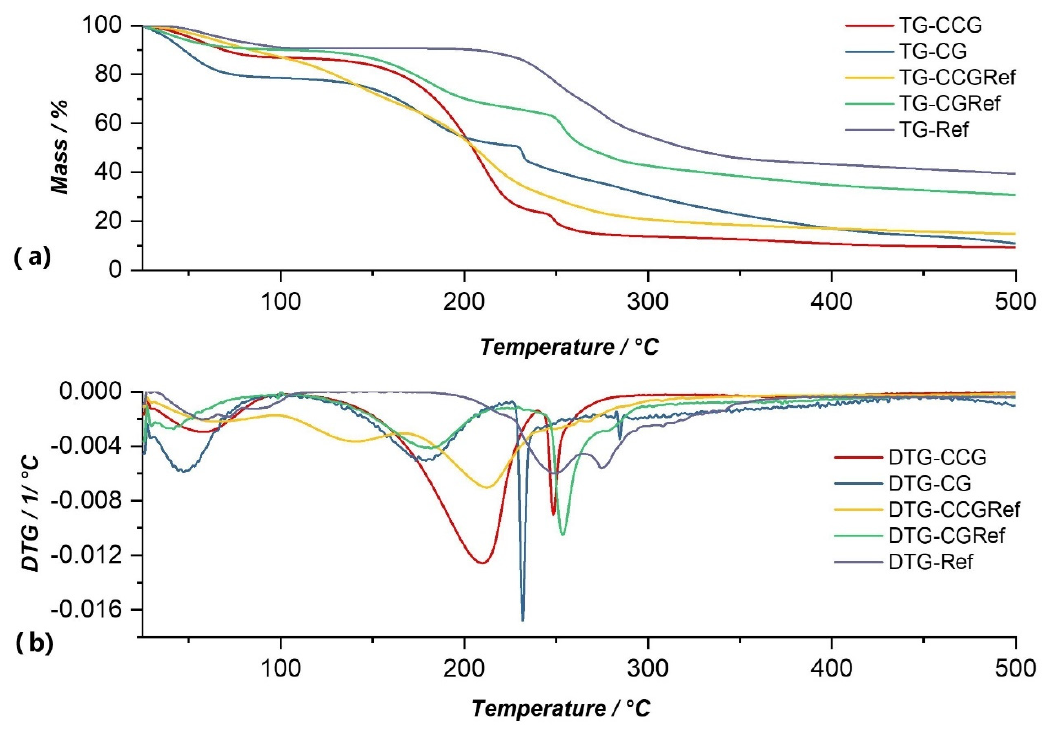
Figure 7 . Comparison of TG ( a ) and DTG ( b ) curves of Ref with membranes in which this substance was incorporated (CCGRef, CGRef), as well as with control membranes (CCG and CG).